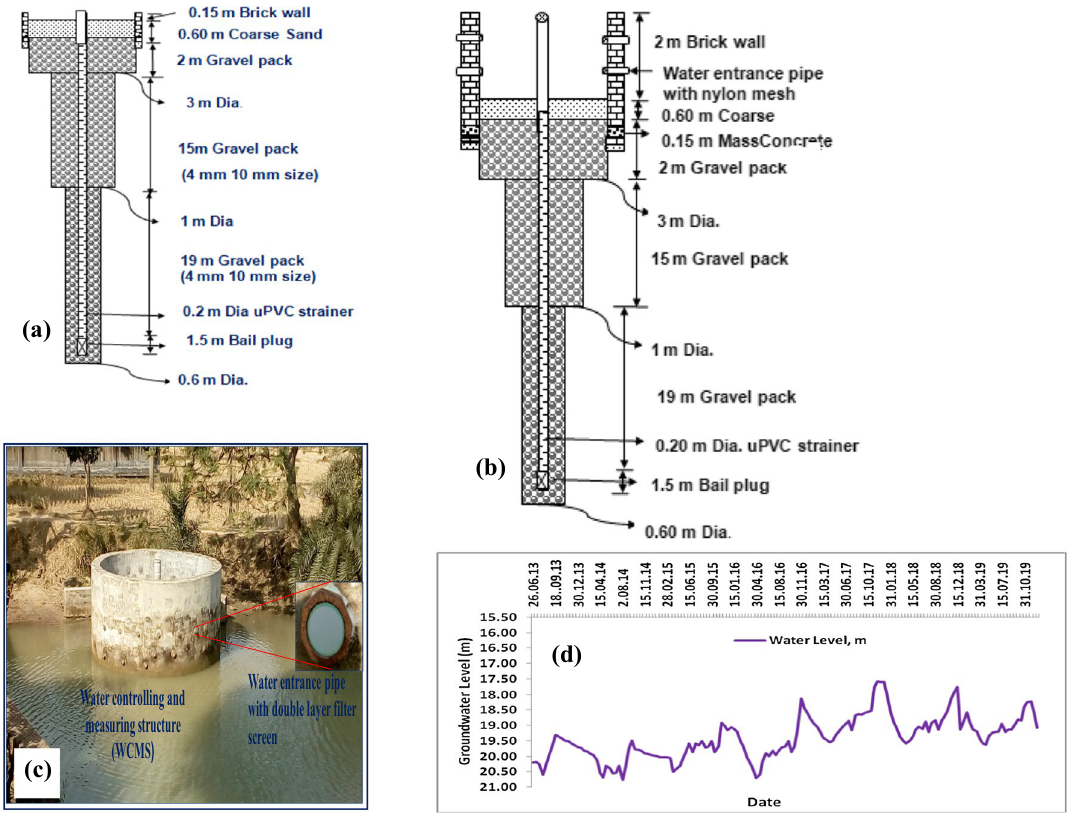
Fig. 8 Sharmangla khari MAR model- a Conventional MAR structure (RW), b Modified and developed MAR structure (RW with WCMS), c Photograph of modified MAR model and d GWL hydrograph showing recharge